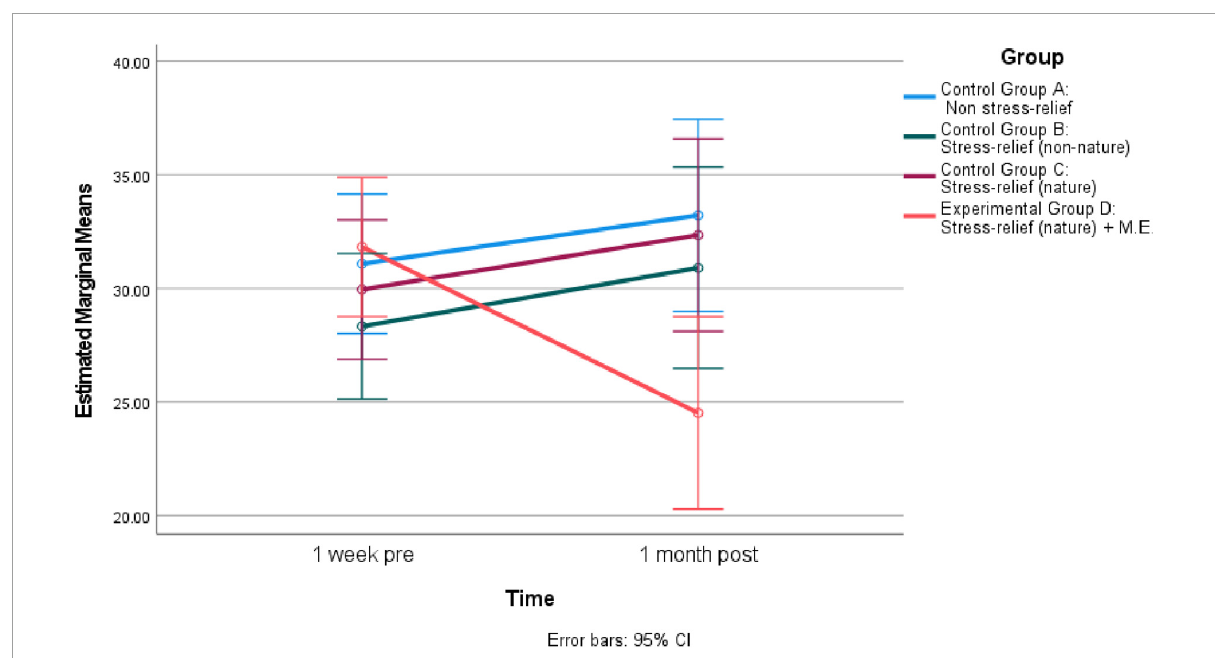
FIGURE4 Estimated marginal means of “Perceived Stress Scale-14” across different time for four groups ( N = 90).